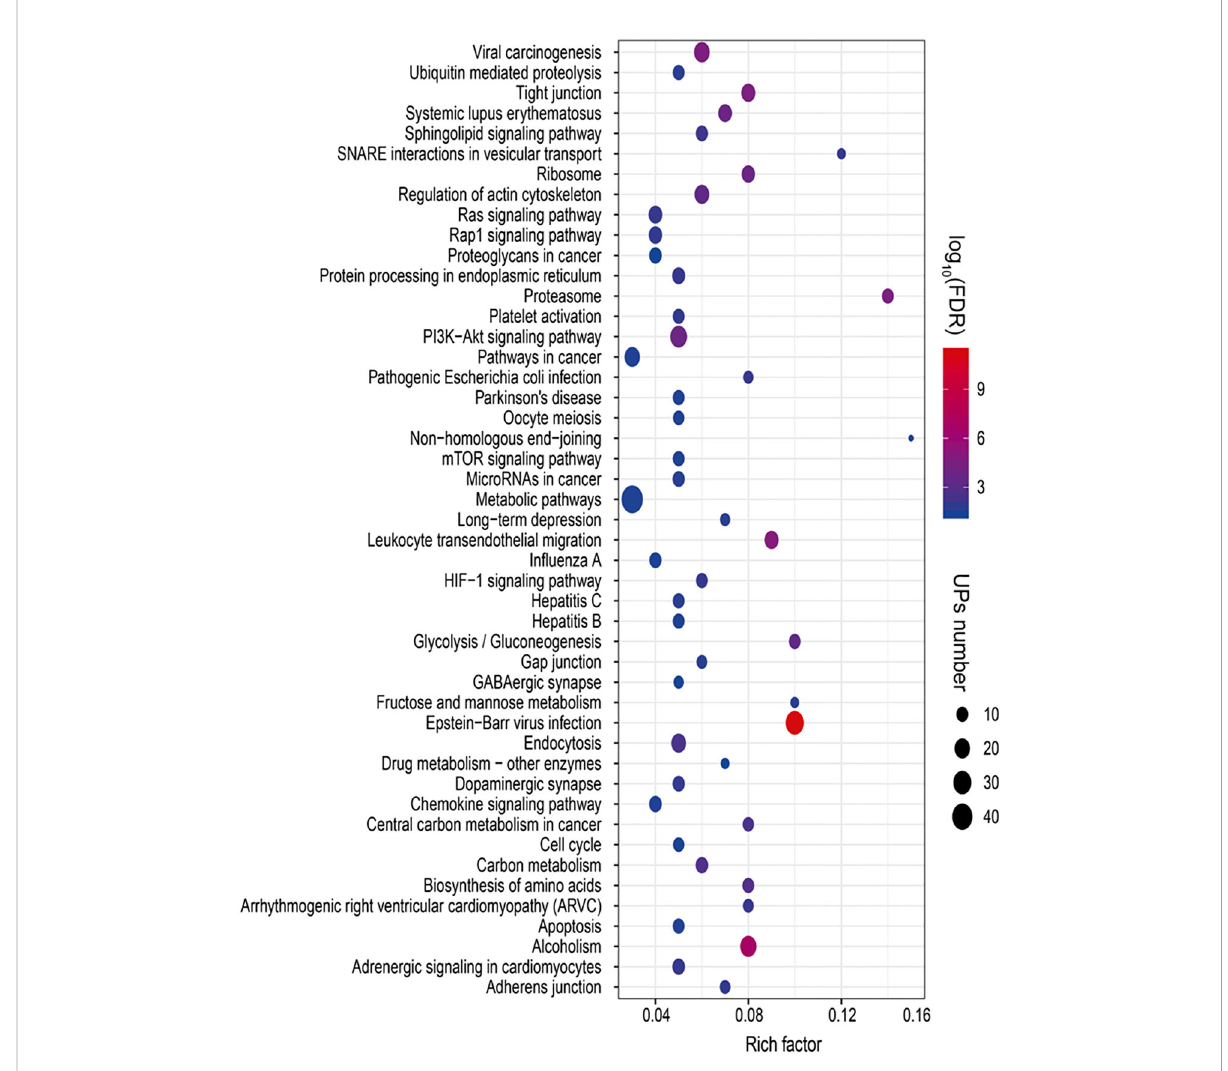
FIGURE 6 Statistically signi fi cant signaling pathways identi fi ed with KEGG pathway analysis of 627 UPs. A total of 47 KEGG pathways was signi fi cantly enriched from those UPs (p < 0.05; FDR <